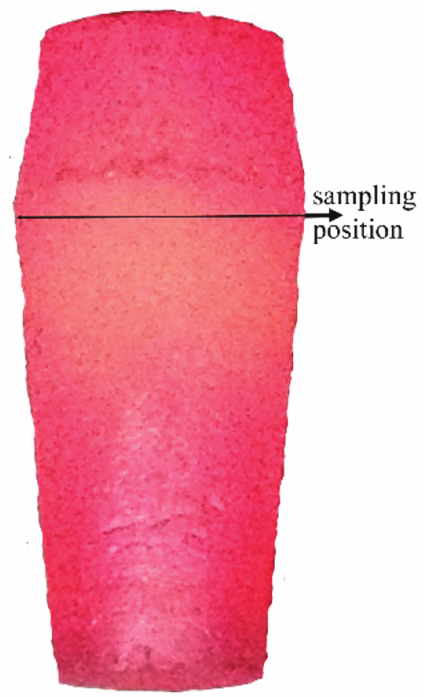
Figure 1: Schematic diagram of sampling position of metallographic